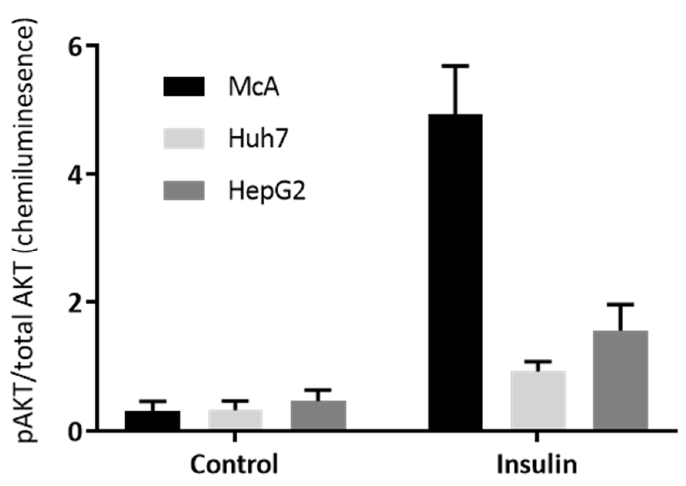
Figure 4. Effect of insulin on the ratio of pAKT to Total AKT in the three Hepatoma cell lines. Insulin sensitivity of McA, Huh7 and HepG2 cells determined by Western blotting for phosphorylated AKT (pAKT) and total AKT. Each cell type was probe on 3 separate gels/antibody ( n = 1 per cell type on each gel) and data presented represents mean ( ± SEM) of the ratio of pAKT/total AKT (n = 3/cell type). Data was analysed by 2-way ANOVA (and a significant interaction between cell type and presence of insulin ( p < 0.001) was found.